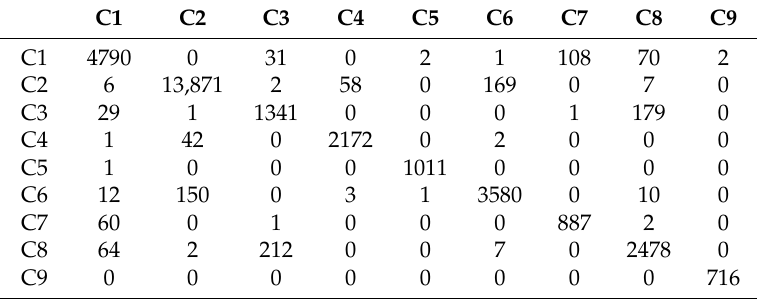
Table 6. The details of classification results for Pavia University data.